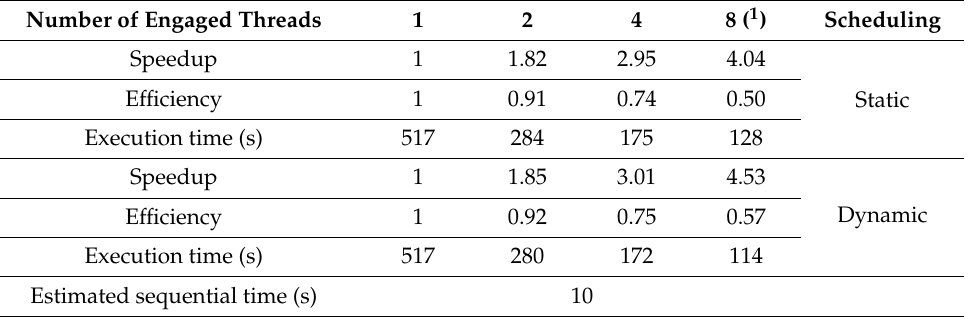
Figure 8. Same as Figure 7, but for platform B. Table 4. Averaged parallel performance achieved on Intel ® Core™ i7-6700HQ CPU (2.60 GHz) architecture (Platform B) for a 16,600 × 14,200 image